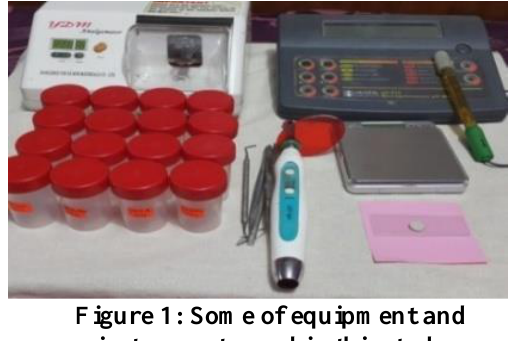
Figure 1: Some of equipment and instruments used in this